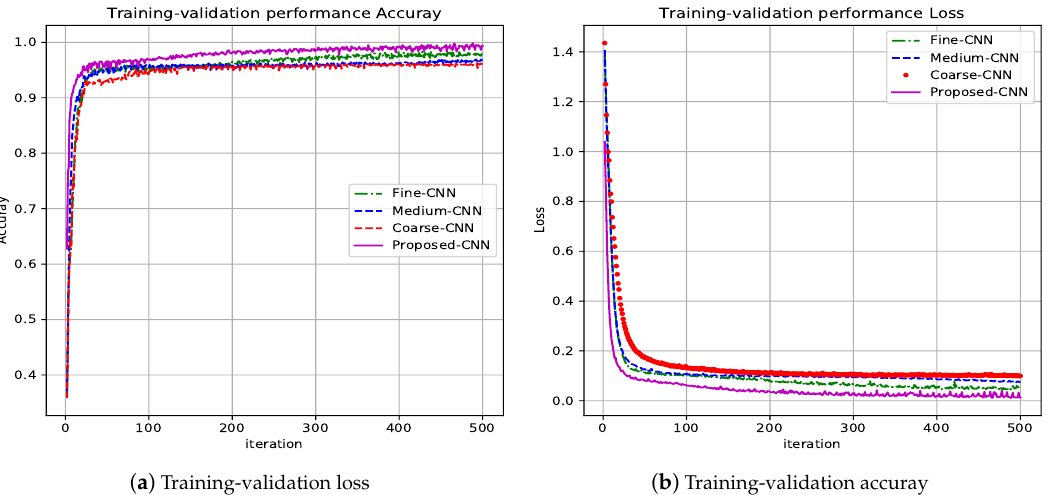
Figure 6. Training-validation results for the proposed CNN